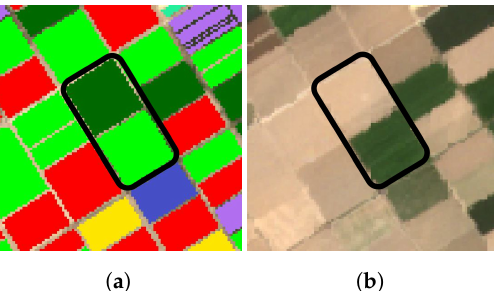
Figure 3. Visualization of an example of suspected mislabeled crops from the Sector BXII crop survey, with confusion between Cotton (green) and Sugar Beet (dark green) crops. ( a ) Superposition of Sentinel-2 RGB image of 22/04/17 and supplied crop types; ( b ) Sentinel-2 RGB image acquired the